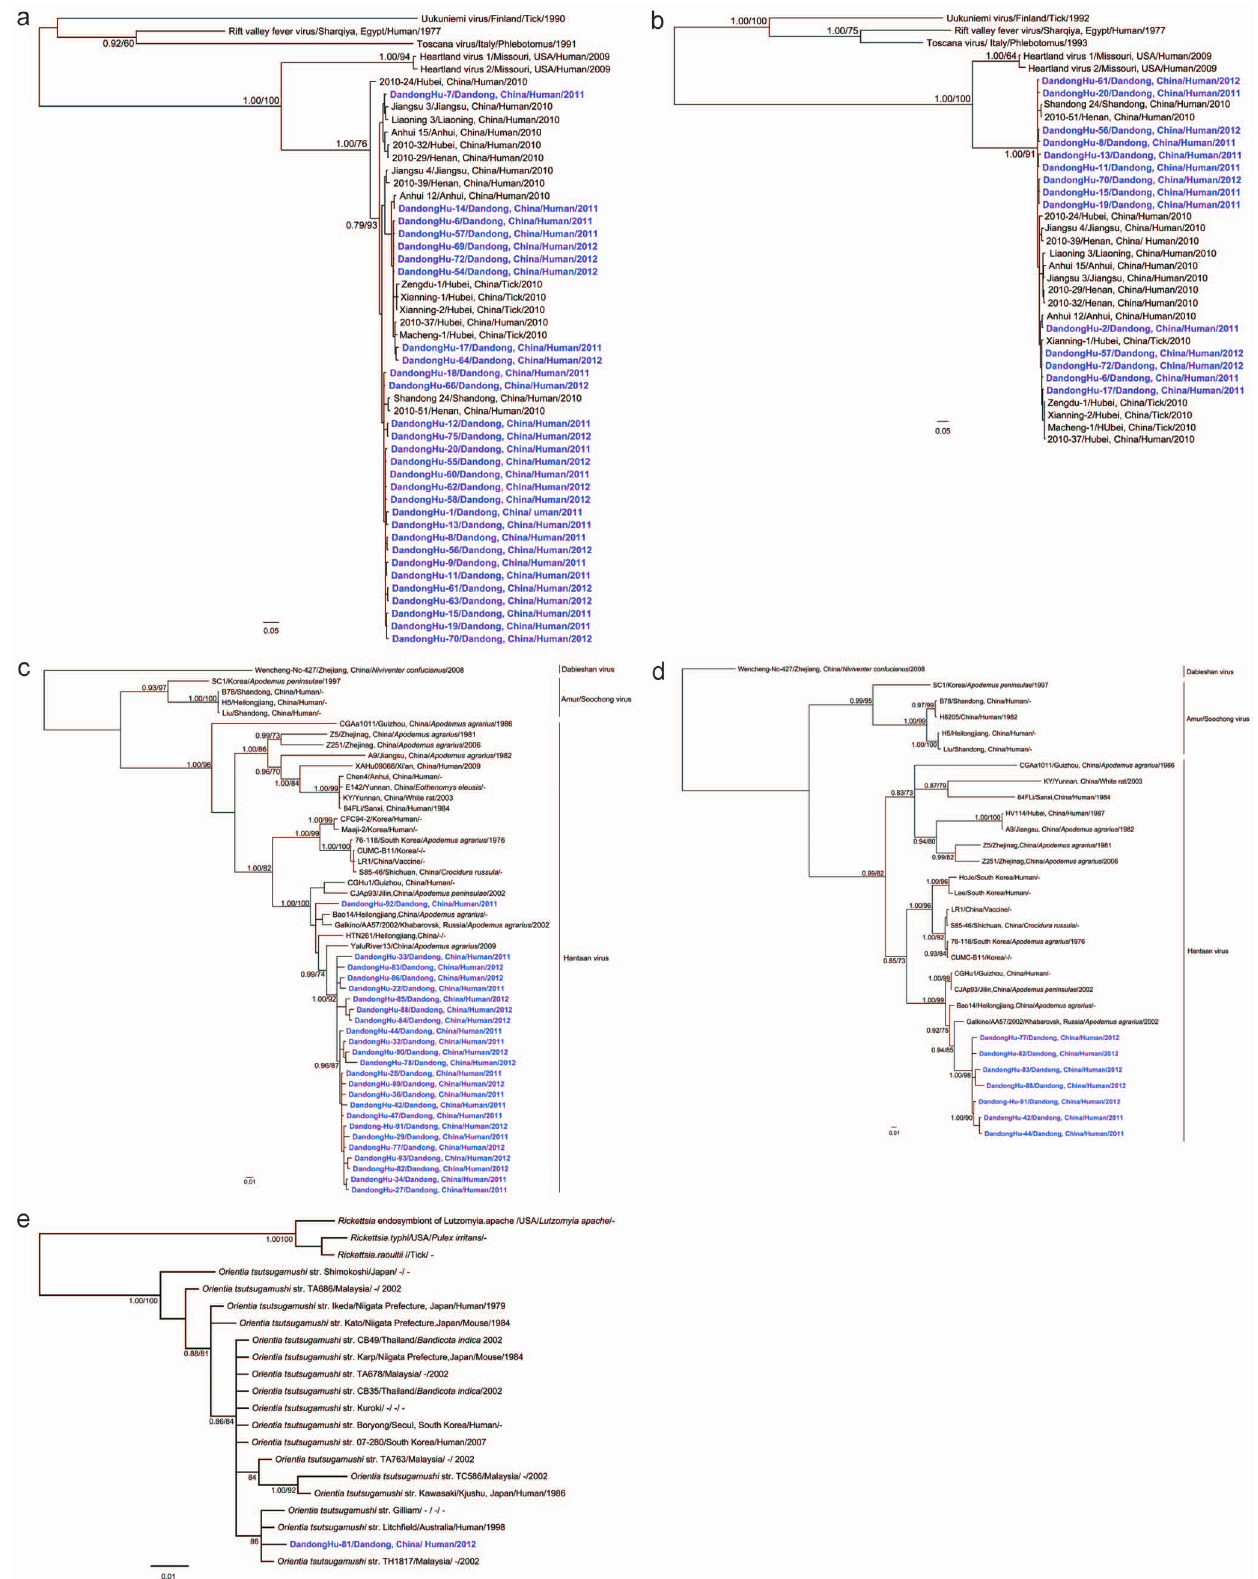
Figure 1. Phylogenetic relationships among Huaiyangshan virus (HYSV) and hantavirus variants found in humans within and outside of China. The Bayesian trees were inferred using the (a) partial S and (b) partial L segment sequences of HYSV, the (c) partial S and (d) partial M sequences of HVs, and (e) the 16S DNA gene of Rickettsiales . The numbers above or below branches indicate posterior node probabilities